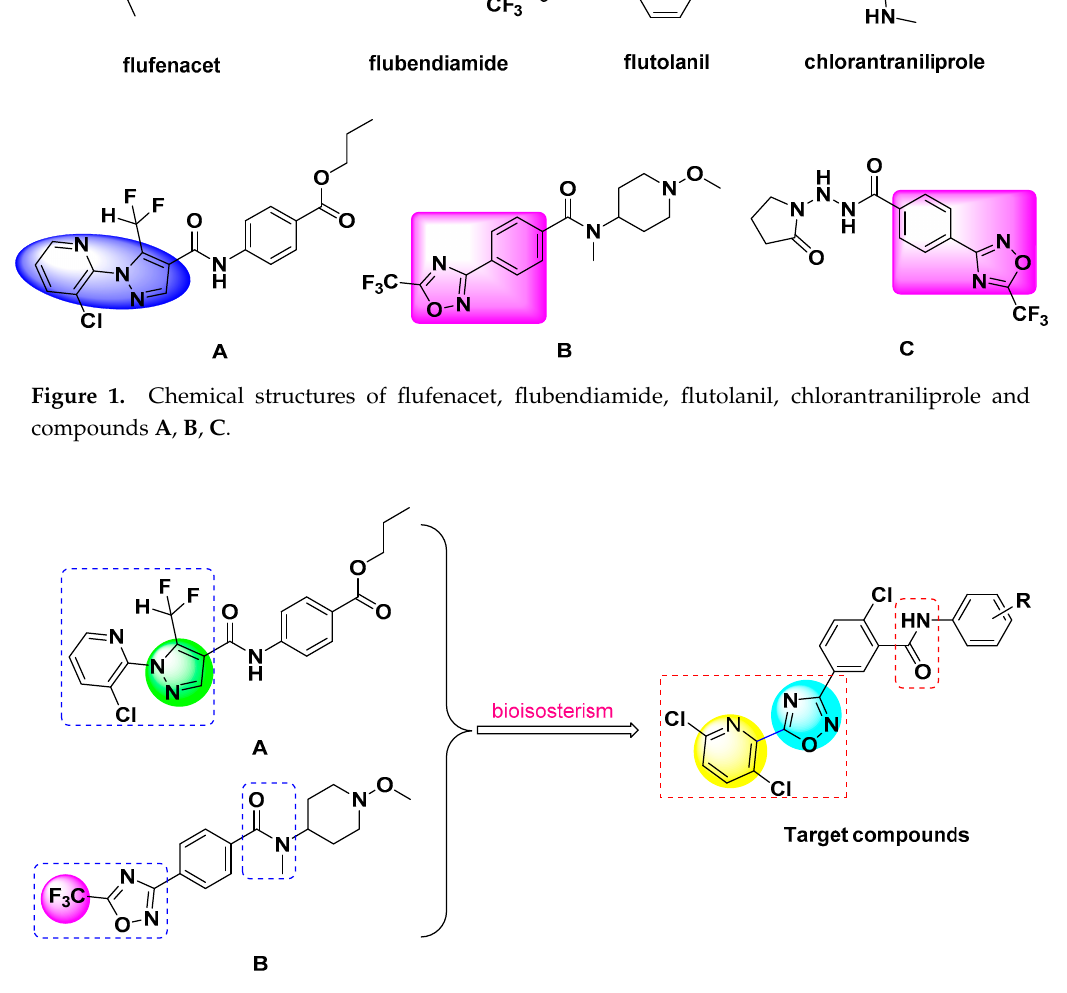
Figure 2. Design strategy of the target compounds.